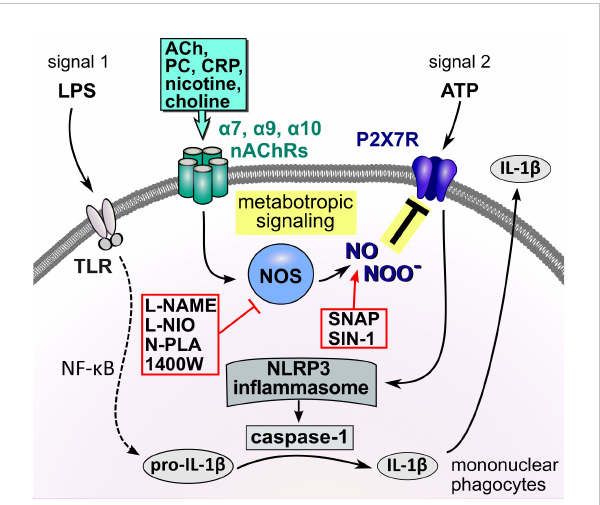
FIGURE 9 Schematic summary of the proposed metabotropic signaling mechanism. In mononuclear phagocytes extracellular ATP originating from activated cells or spilled cytoplasm of damaged cells trigger the ionotropic function of the P2X7R, resulting in NLRP3 in fl ammasome assembly, activation of caspase-1, cleavage of pro- IL-1 b and release of bioactive IL-1 b . Activation of nAChRs by classical and unconventional agonists down-regulates the response of the ATP-sensitive P2X7R, impairs NLRP3 in fl ammasome assembly and, consequently, the maturation as well as the release of IL-1 b . We provide evidence that this inhibitory effect of nAChR stimulation on the secretion of IL-1 b is mediated via endothelial NOS and modi fi cation of the P2X7R. ACh, acetylcholine; ATP, adenosine triphosphate; CRP, C-reactive protein; DAMP, danger-associated molecular pattern; IL-1 b , interleukin-1 b ; LPS, lipopolysaccharide; nAChRs, nicotinic acetylcholine receptors; NF- k B, nuclear factor k B; NLRP3, NACHT, LRR, and PYD domains-containing protein 3; NOS, NO synthase; P2X7R, P2X7 receptor; PAMP, pathogen-associated molecular pattern; PC, phosphocholine; SNAP, S-nitroso-N-acetyl- DL-penicillamine; TLR, Toll-like